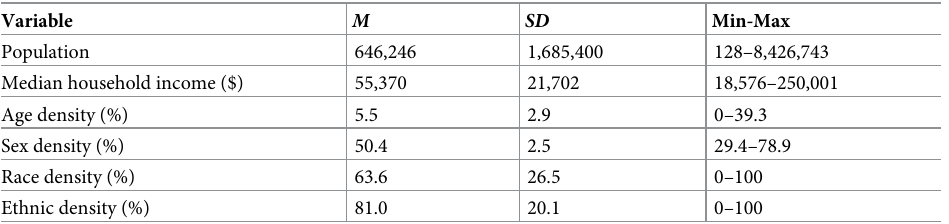
Table 2. Variables from the US Census (N =